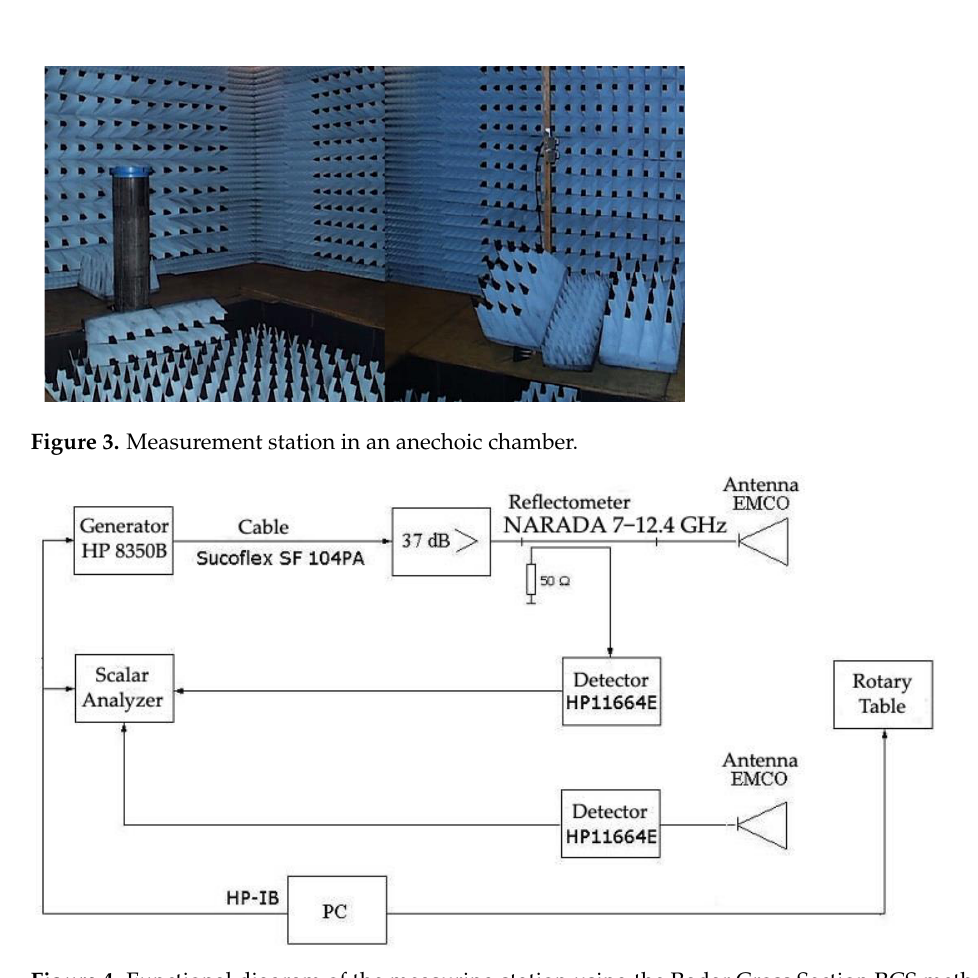
Figure 4. Functional diagram of the measuring station using the Radar Cross Section RCS method.